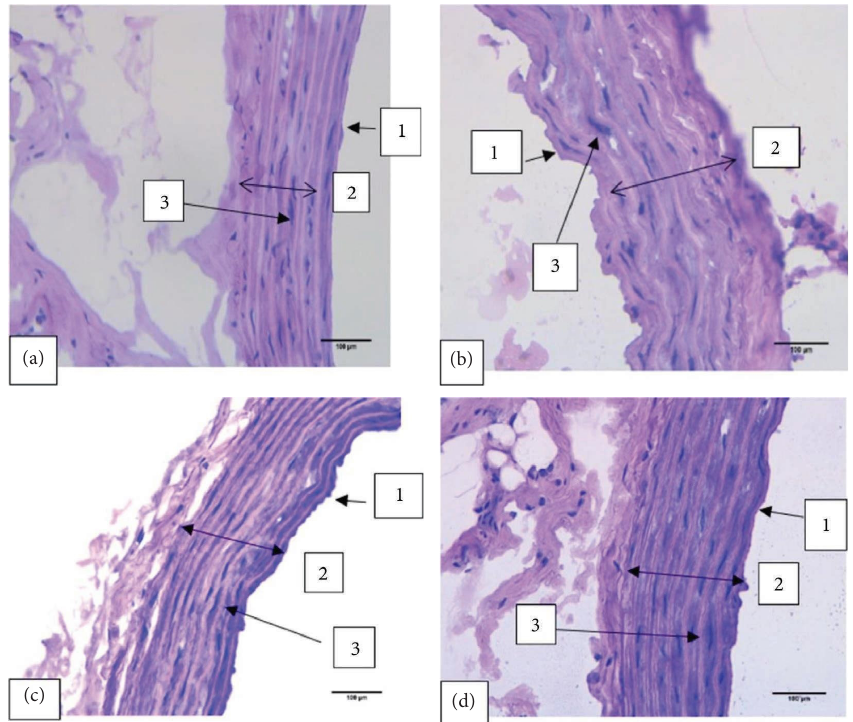
Figure 11: Microscopic view of the aortic wall stained with hematoxylin-eosin at 400 × magnifcation. Tunica intima (endothelial) de- tachment and an irregularity in the arrangement of collagen fbers and smooth muscle cells in the tunica media were observed in the hyperglycemic control group. (a) Control group. (b) Hyperglycemic control group. (c) Hyperglycemic rats that performed moderate- intensity continuous training (MICT). (d) Hyperglycemic rats that performed high-intensity interval training (HIIT). (1) Tunica intima. (2) Tunica media. (3) Smooth muscle cells